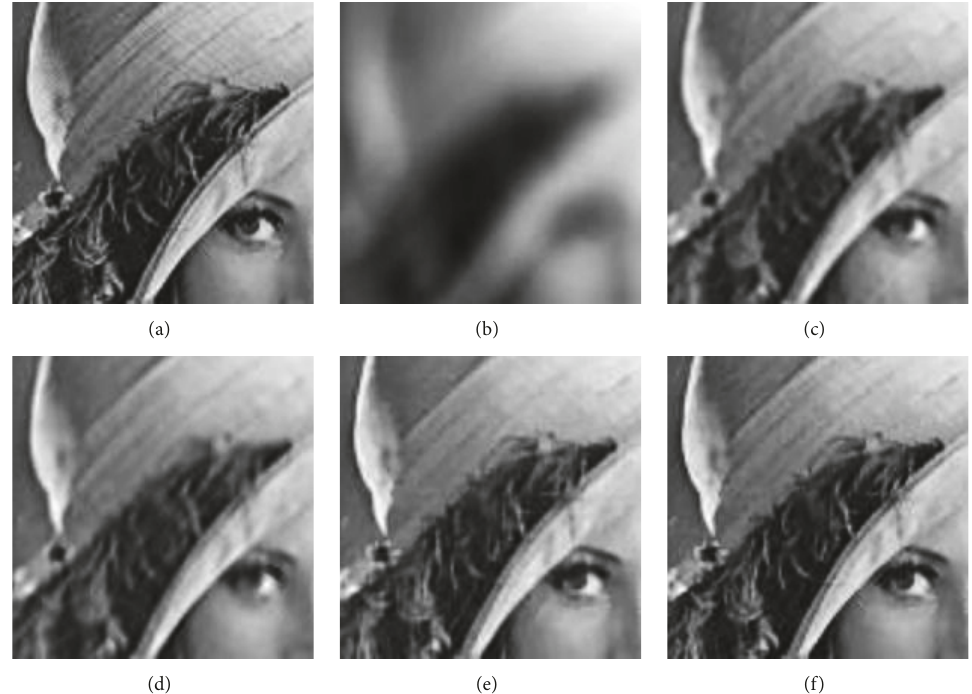
Figure 10: The zoomed regions of the results of Figure 9. (a) Original image; (b) blurred and noisy image; (c) image recovered by FTVd; (d) image recovered by TGV; (e) image recovered by TVframe; (f) image recovered by